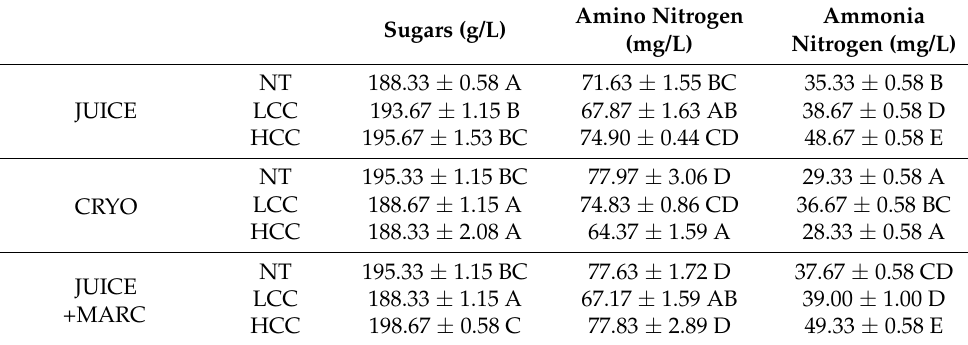
Table 2. Initial composition of musts and grape